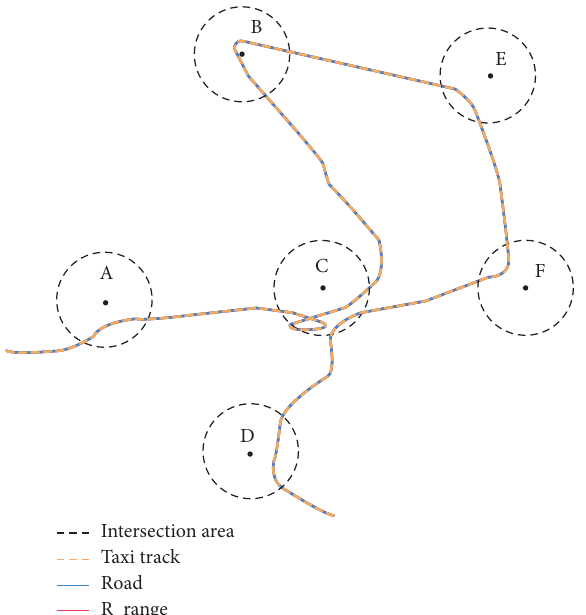
Figure 4: The method of traffic flow statistics of each observation port.